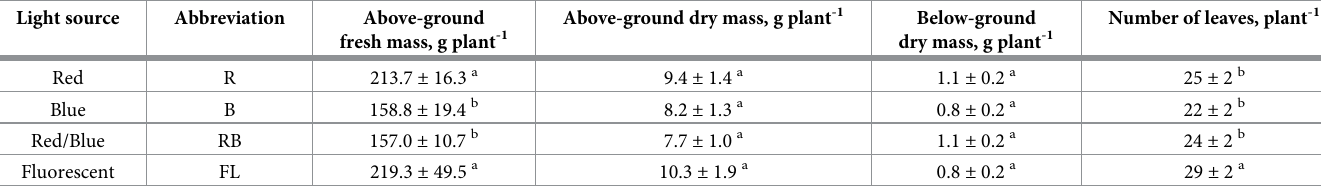
Table 2. Phenotypic characteristics in the plants grown under different light